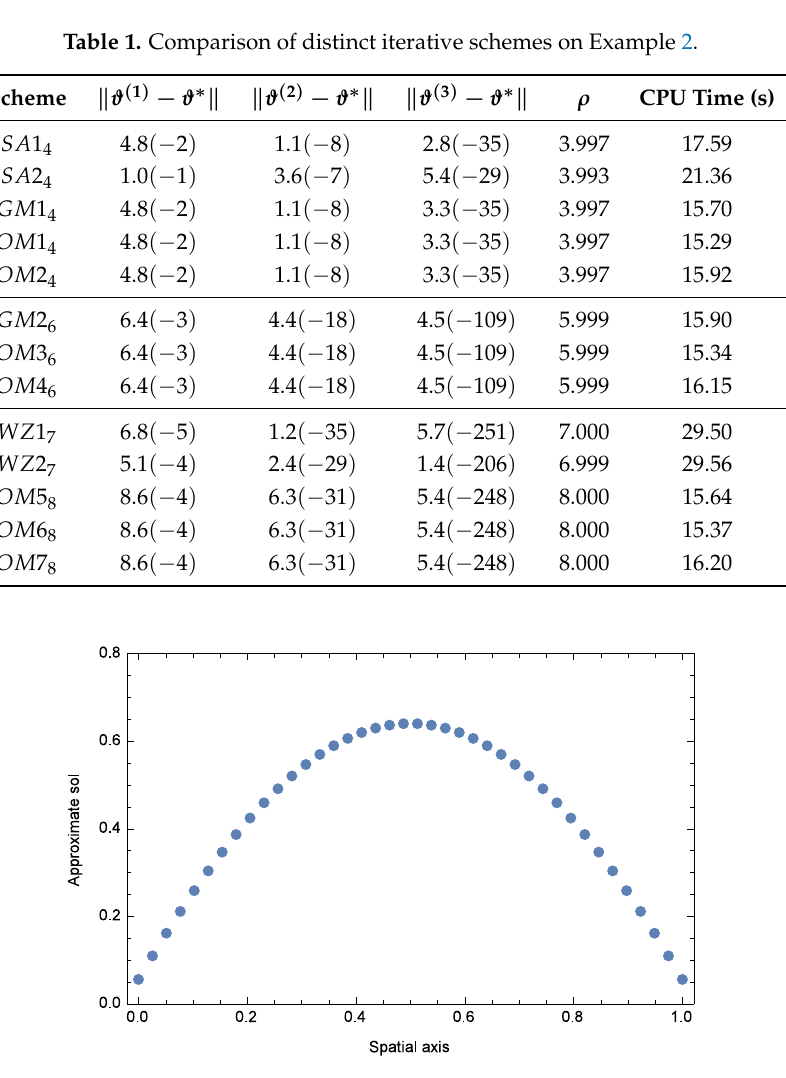
Figure 1. Approximated solution of Bratu problem with C = 3 for t ∈ [ 0,1 ] . Table 2. Comparison of distinct iterative schemes on 2D Bratu problem Example 3.